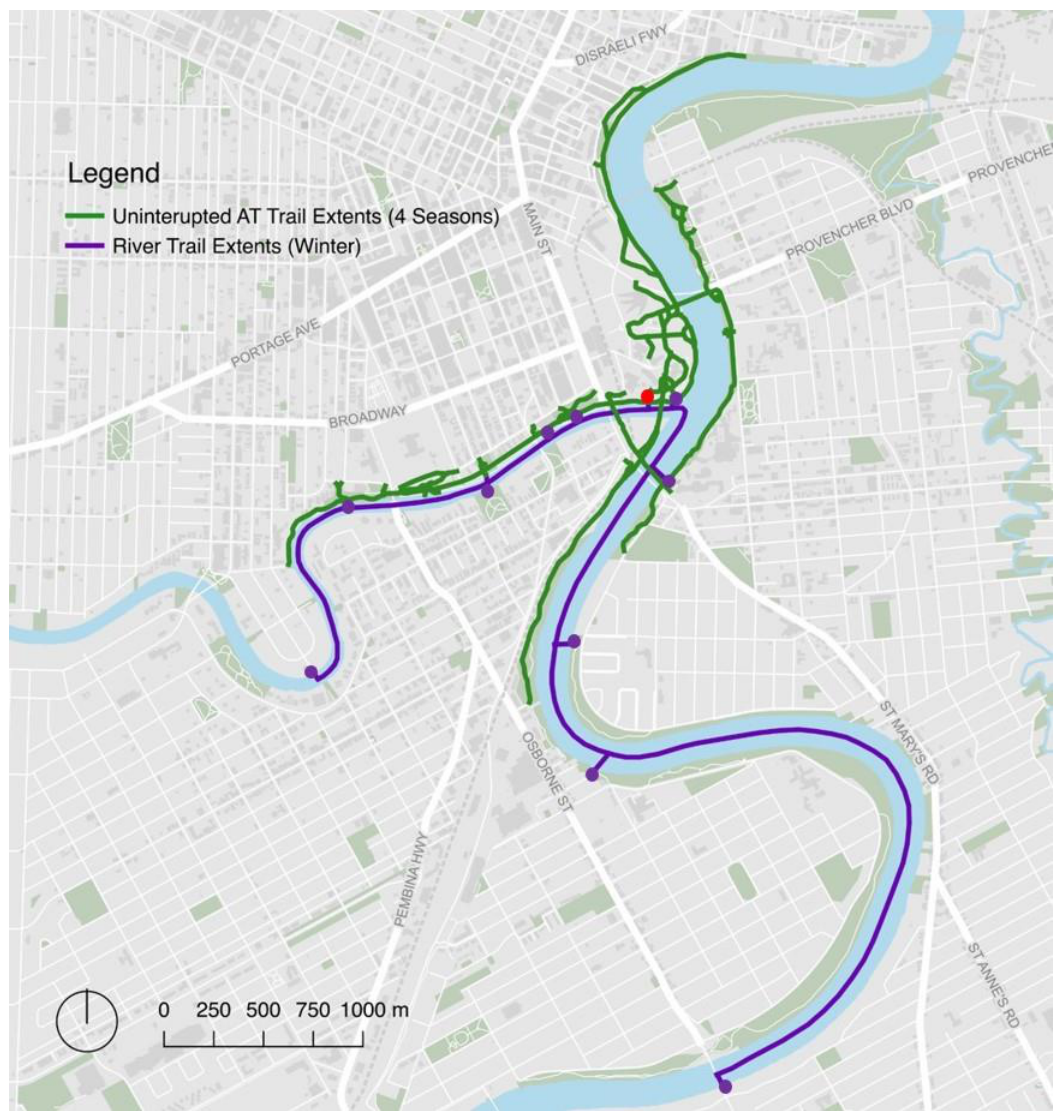
Figure 2. Map of trail network. Red dot = location of PYRO-Box Eco-Counter; purple dots = access points for the frozen waterway trail; green lines = permanent trail network accessible for 12 months of the year; purple line = frozen waterway trail.